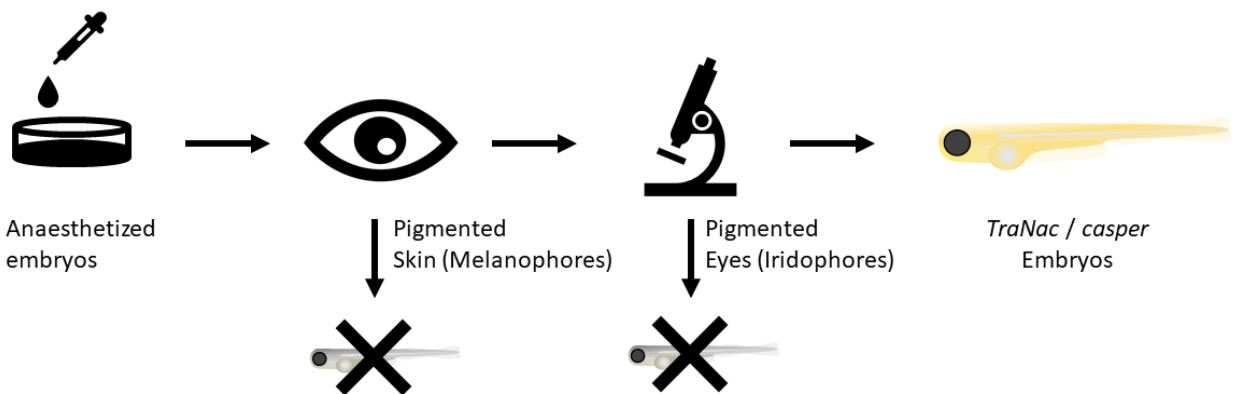
Figure 4. Screening procedure. Fish are anaesthetized in 4.2% MS-222 (168 µg/mL). Thereafter simple visual screening of larvae allows WT and tra fish to be discarded. The next step is fluorescent microscopy screening using the mCherry filter for different colour patterns in the eyes of the fish (see Figure 3). If TraNac or casper fish are desired, one screens for fish without any eye pigmentation . TraNac = tra b6/b6 ; nac w2/w2 zebrafish